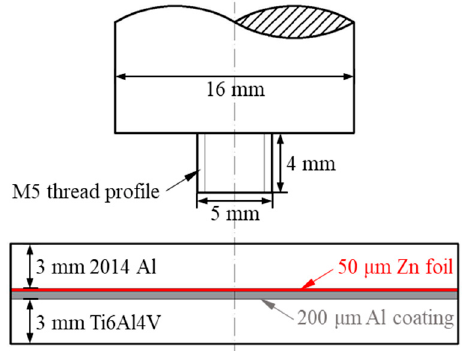
Figure 2. Schematic of the set-up used in the friction stir spot welding-brazing (FSSW-B) process.